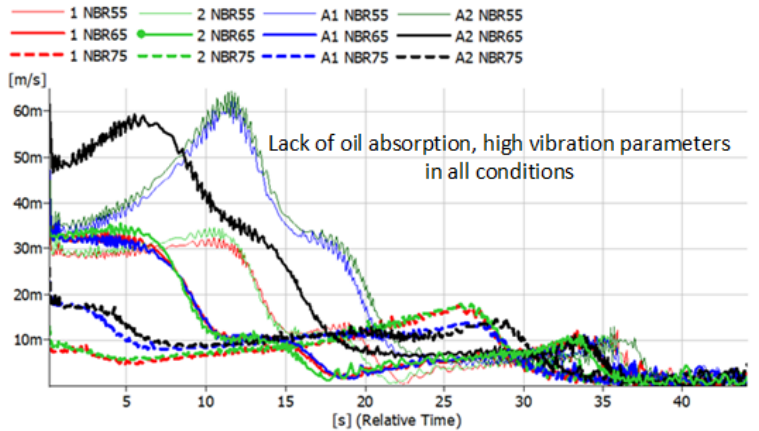
Figure 14. Vibration parameters during the run-down process with NBR rubber absorbers installed in the vibration insulation system.